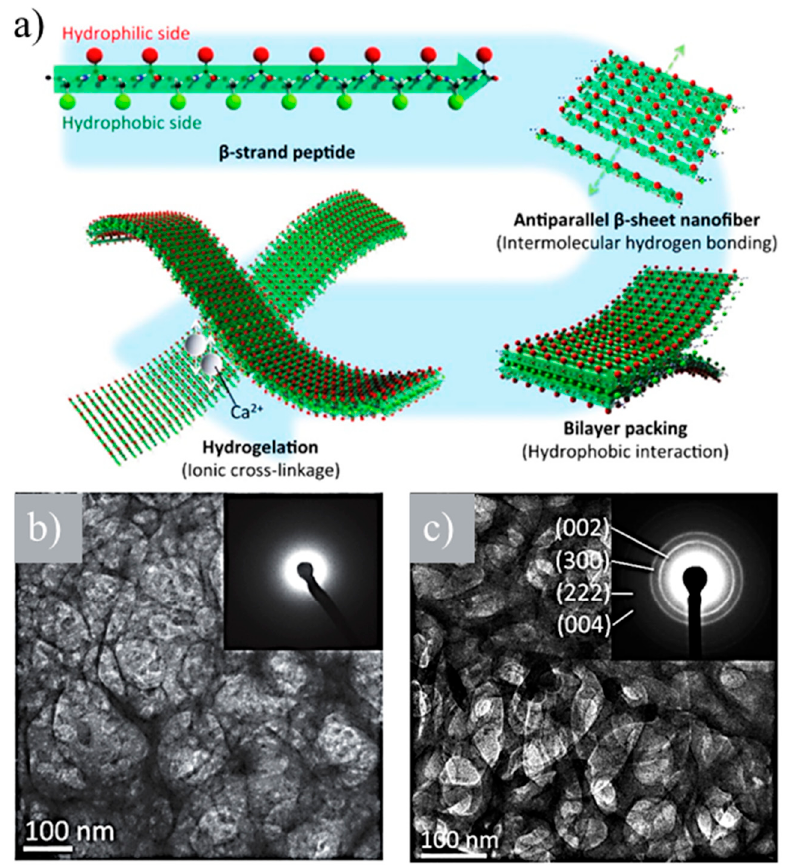
Figure 14. ( a ) β -strand (LE) 8 and (VEVSVKVS) 2 peptides formed antiparallel β -sheets, which packed face-to-face together through hydrophobic interactions between the two hydrophobic sides. The hydrophilic surfaces of bilayer nanofibers were subsequently able to cross-link by the ionic interaction between the anionic carboxyl group and the cationic calcium ion. ( b ) TEM image and amorphous calcium phosphate (ACP) amorphous electron diffraction pattern (inset) of the network derived from calcium phosphate and (LE) 8 peptide. ( c ) TEM image and HAp crystalline electron diffraction pattern (inset) of the network derived from calcium phosphate and (VEVSVKVS) 2 peptide. Reproduced from [98].